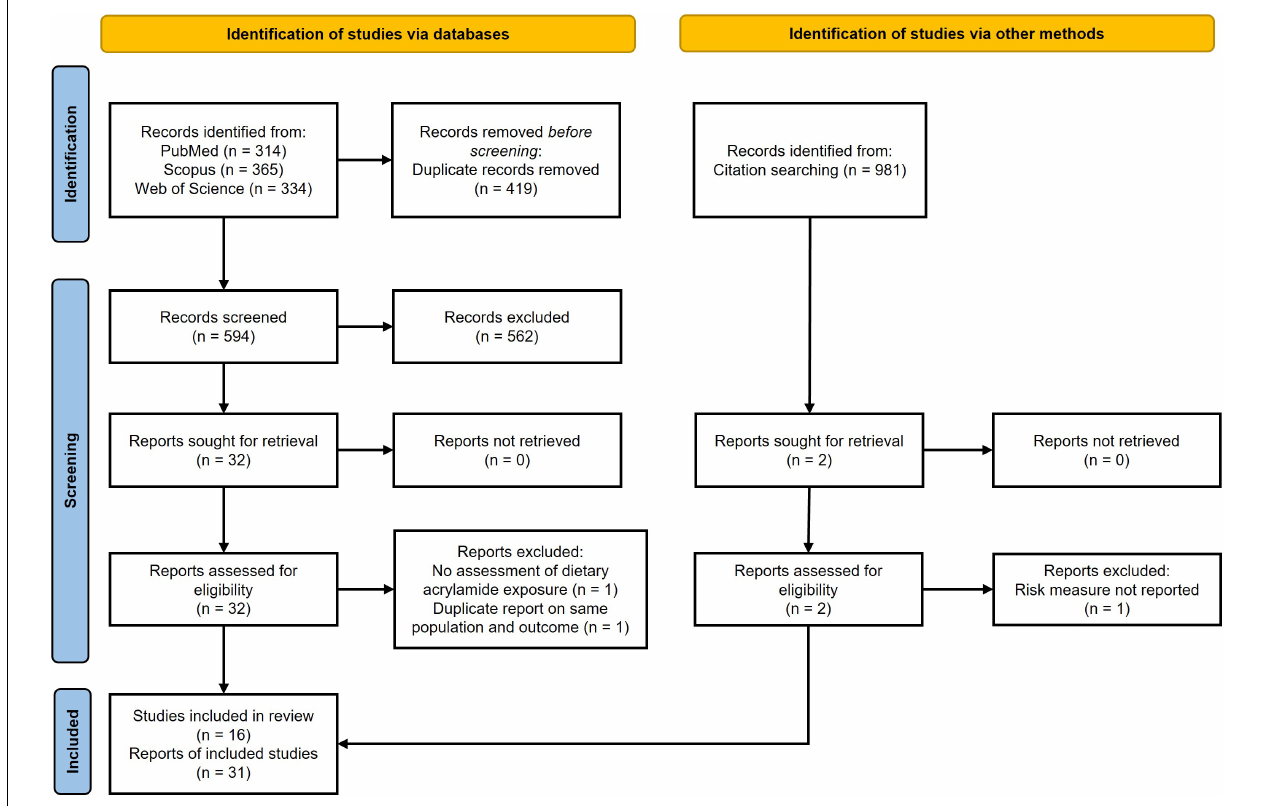
FIGURE 1 | Flow chart of the included study following PRISMA